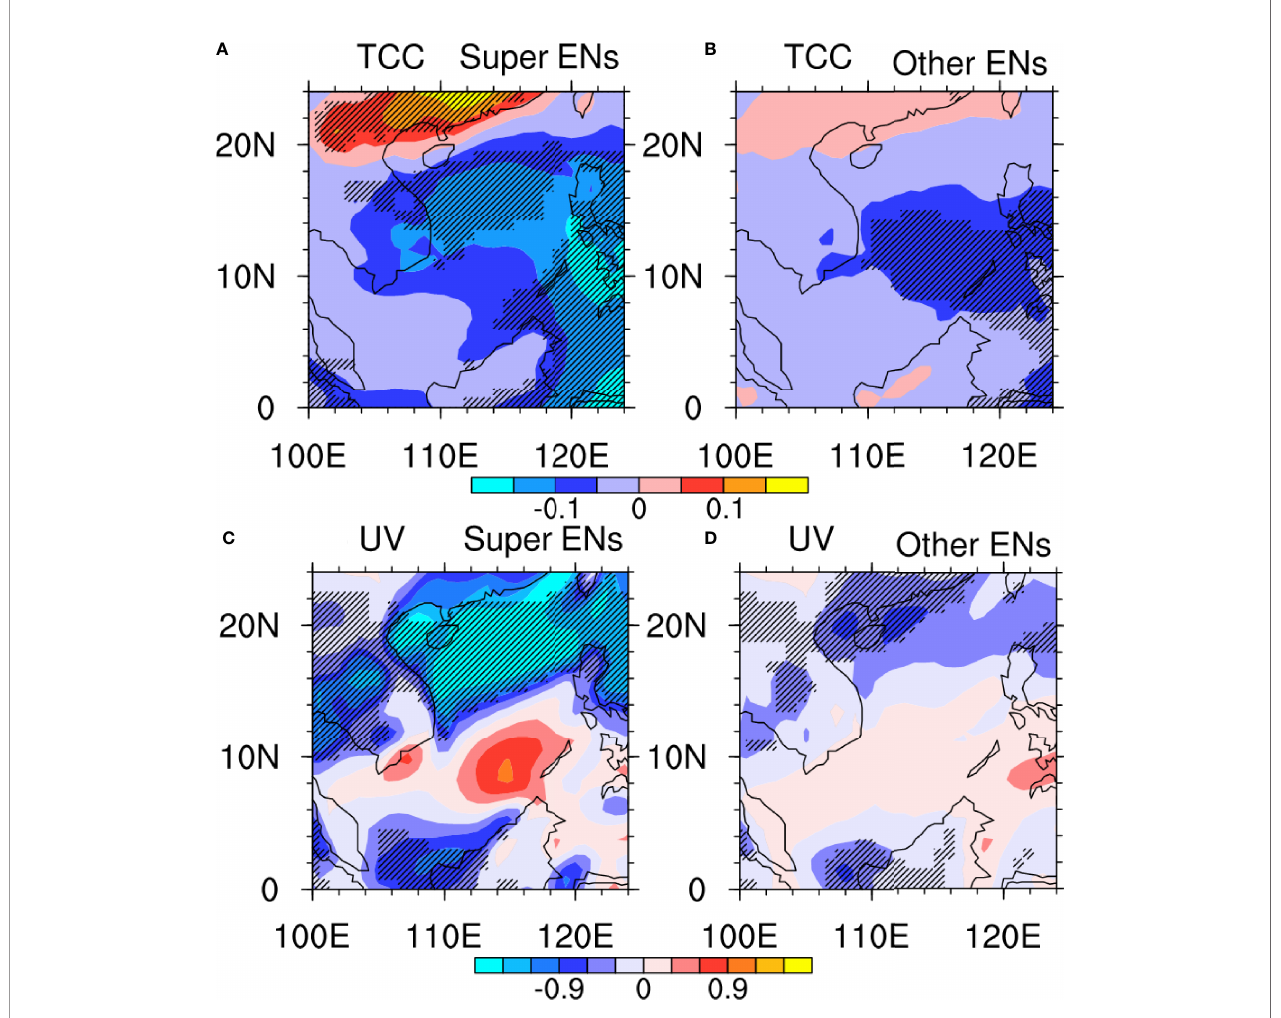
FIGURE 7 | (A) The total cloud cover (TCC) anomalies averaged over OND(0) for super El Niño composite. (B) Same as in (A) but for other El Niño composite. (C) The wind speed anomalies averaged over OND(0) for super El Niño composite (Unit: m/s). (D) Same as in (C) but for other El Niño composite. The composite results exceeding the 90% con fi dence level are hatched based on Student ’ s t